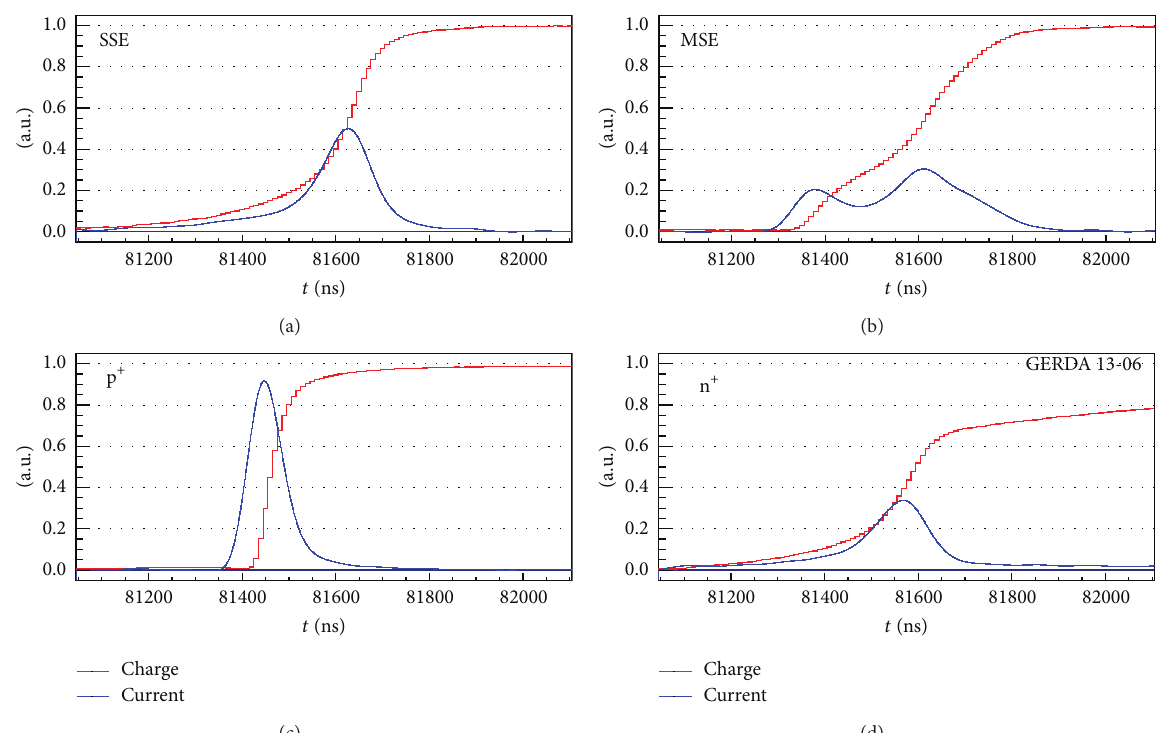
Figure 9: Examples of pulse traces taken from SSE data (a), MSE (b), p + electrode event (c), and n + surface event (d). The pulse traces are normalized in order to have the maximum of the charge pulse equal to one, current pulses have equal integrals. From